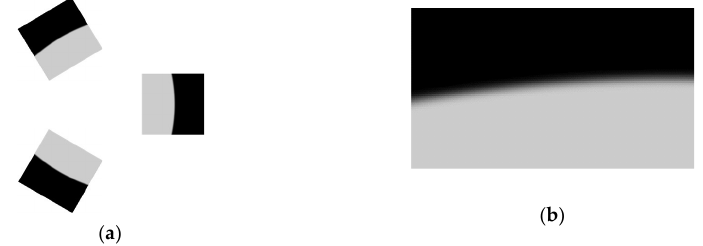
Figure 3. ( a ) Cluster of three simulated limb images and ( b ) detail of the edge region highlighting the blur induced by the atmosphere model